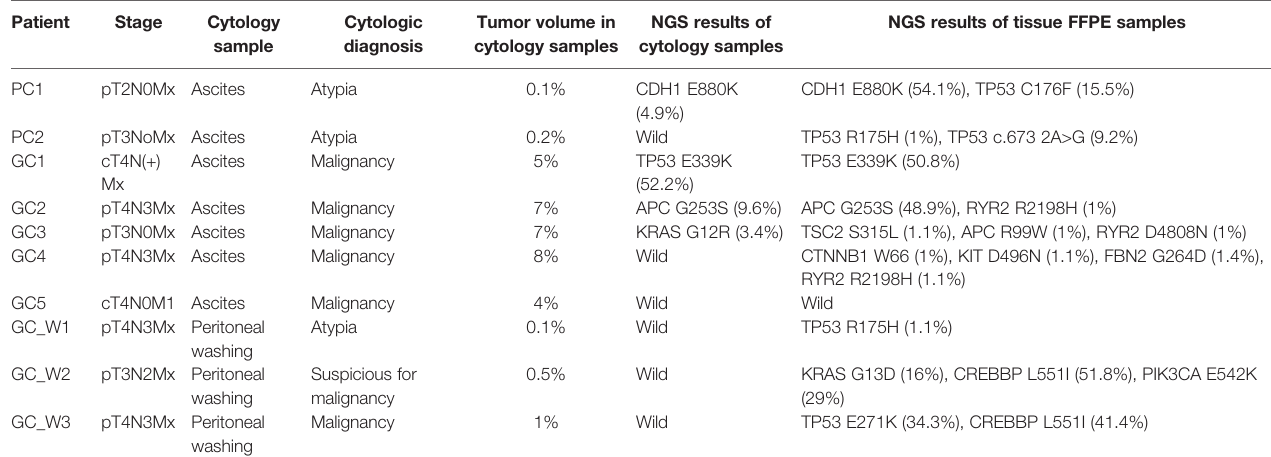
TABLE 3 | Comparison of NGS results in cytology and tissue samples (n =